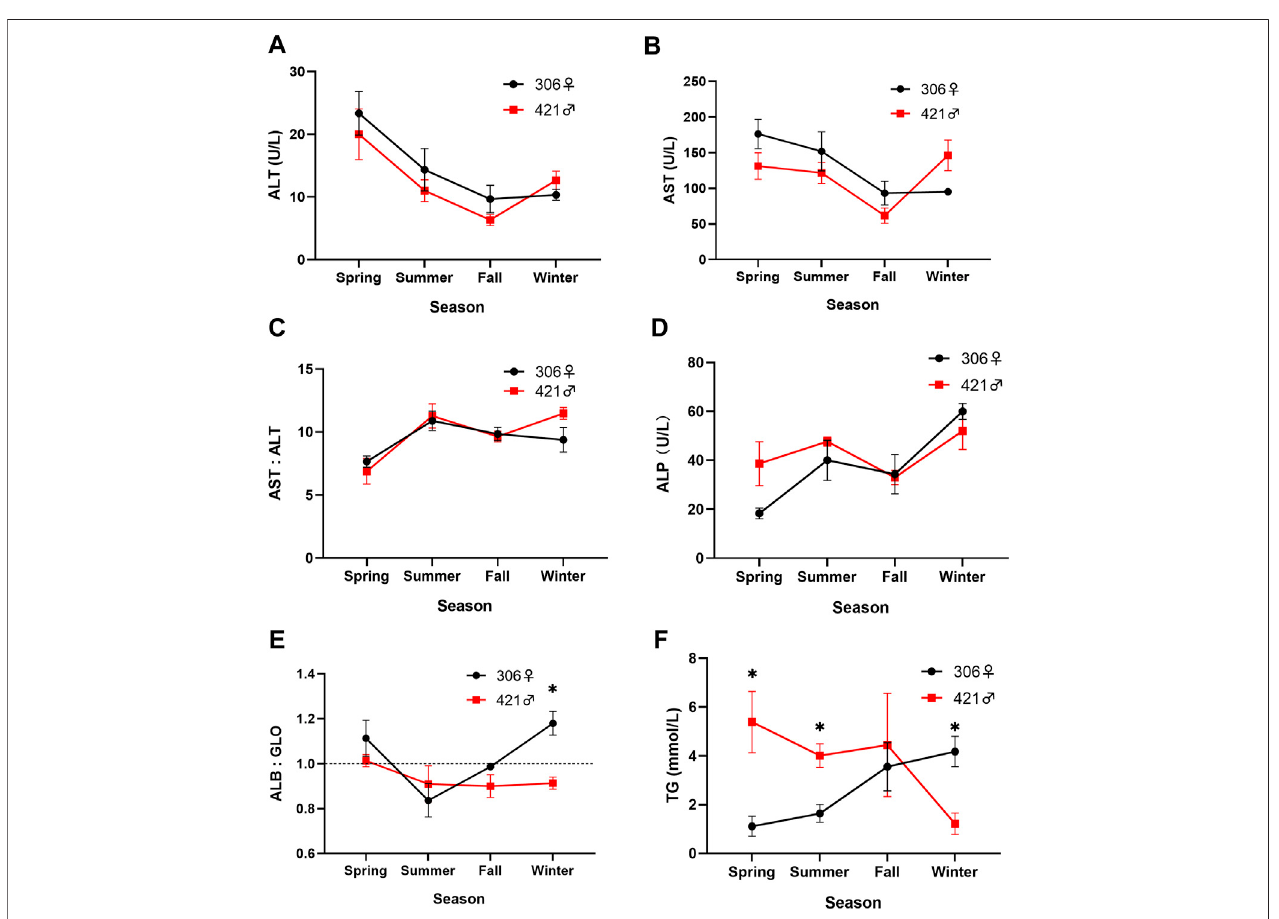
FIGURE 4 | Seasonal variation of (A) alanine aminotransferase (ALT), (B) aspartate aminotransferase (AST), (C) transaminase ratio (AST:ALT), (D) alkaline phosphatase (ALP), (E) albumin to globulin ratio (ALB:GLO), and (F) triglycerides (TG) content in the blood of the two Chinese sturgeons. Data are mean ± SEM ( n = 3), the seasonal data of sample size ( n = 3) represents the three monthly data within one season. Signi fi cant difference ( p < 0.05) in the parameter between the male and female individuals in the same season is denoted by an asterisk. Dashed line represents ratio of 1.0.